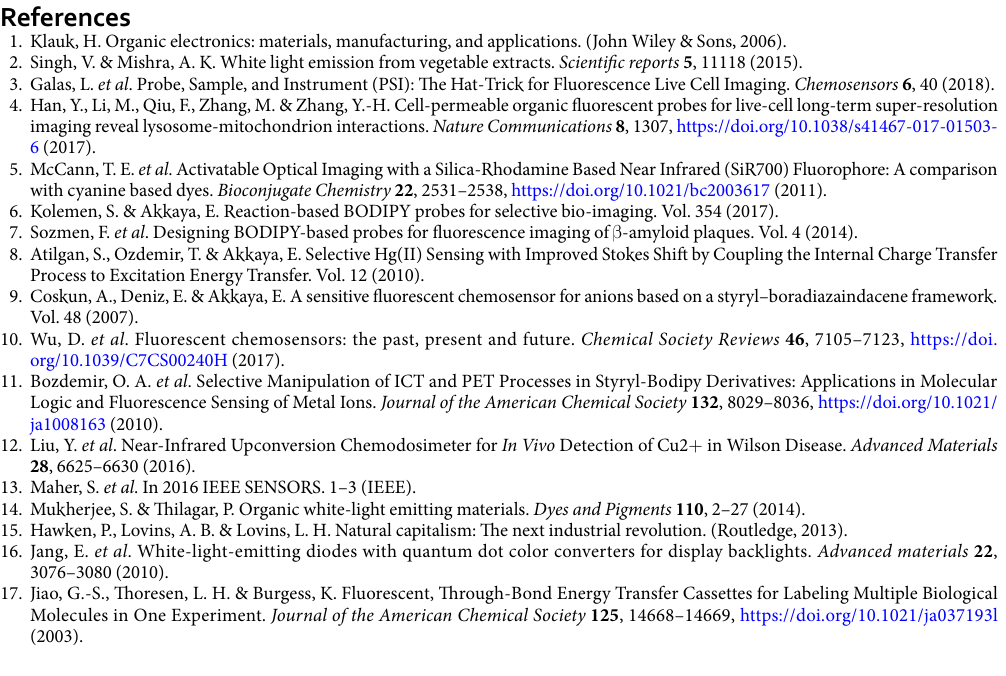
Dansyl chloride (2.69 g, 10 mmol, 1 eq.) and aniline (9.30 g, 10 mmol, 1 eq.) were dissolved and stirred in acetonitrile (50 mL) overnight (Fig. 9). The pure compound was obtained by recrystallization from distilled water and ethanol to produce up to 65% yield (2.12 g). Analysis was in agree- ment with the literature 45 . Figure 9 shows the schematic of the reaction. Yellow powder, m.p. = 131–133 °C, FTIR = 3270 (NH), 2833 (N-CH 3 ), 1601 (NH-aromatic), 1349 (SO 2 -NH), 1159 (SO 2 stretching). 1 H NMR (400 MHz, CDCl